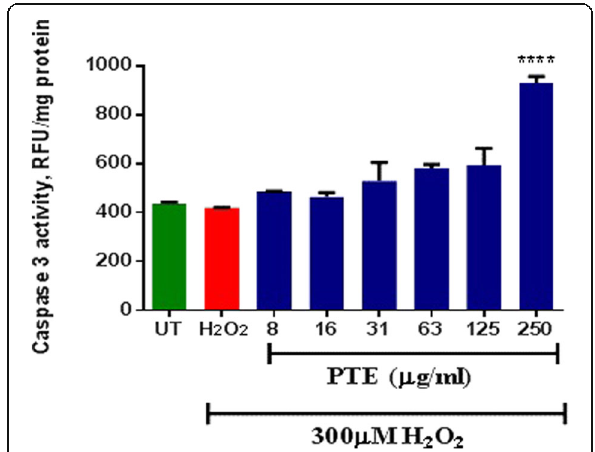
Fig. 5 Effect of PTE pre-treatment (24 h) prior to H 2 O 2 induced cyto- toxicity on the Caspase 3 activity in dIMR32 cells. The data are expressed as mean ± SEM, n = 3. The label UT = untreated control cells. Data represented as relative fluorescence unit (RFU) / μ g protein. Statistical significance was analyzed with one way ANOVA followed by Dunnett ’ s multiple comparison post-hoc test.